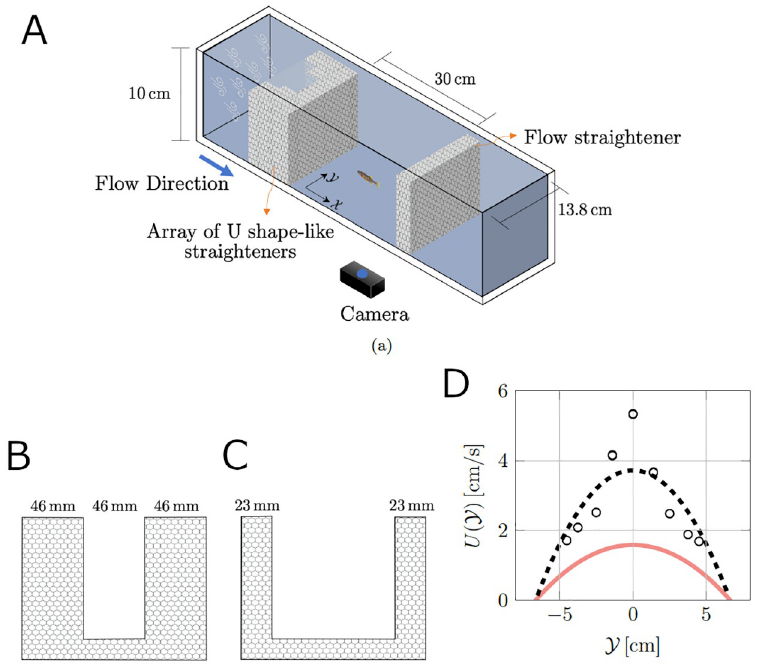
Fig 6. Experimental set-up. (A) Overview of the experimental apparatus. (B,C) U shape-like honeycomb grids for straightening the flow in the water channel. (D) Measurements of the flow velocity profile (black circles) and parabolic fit (black dash line) at the mid-span using laser Doppler velocimetry, along with the parabolic fit of flow profile from fish locomotion (solid red line).